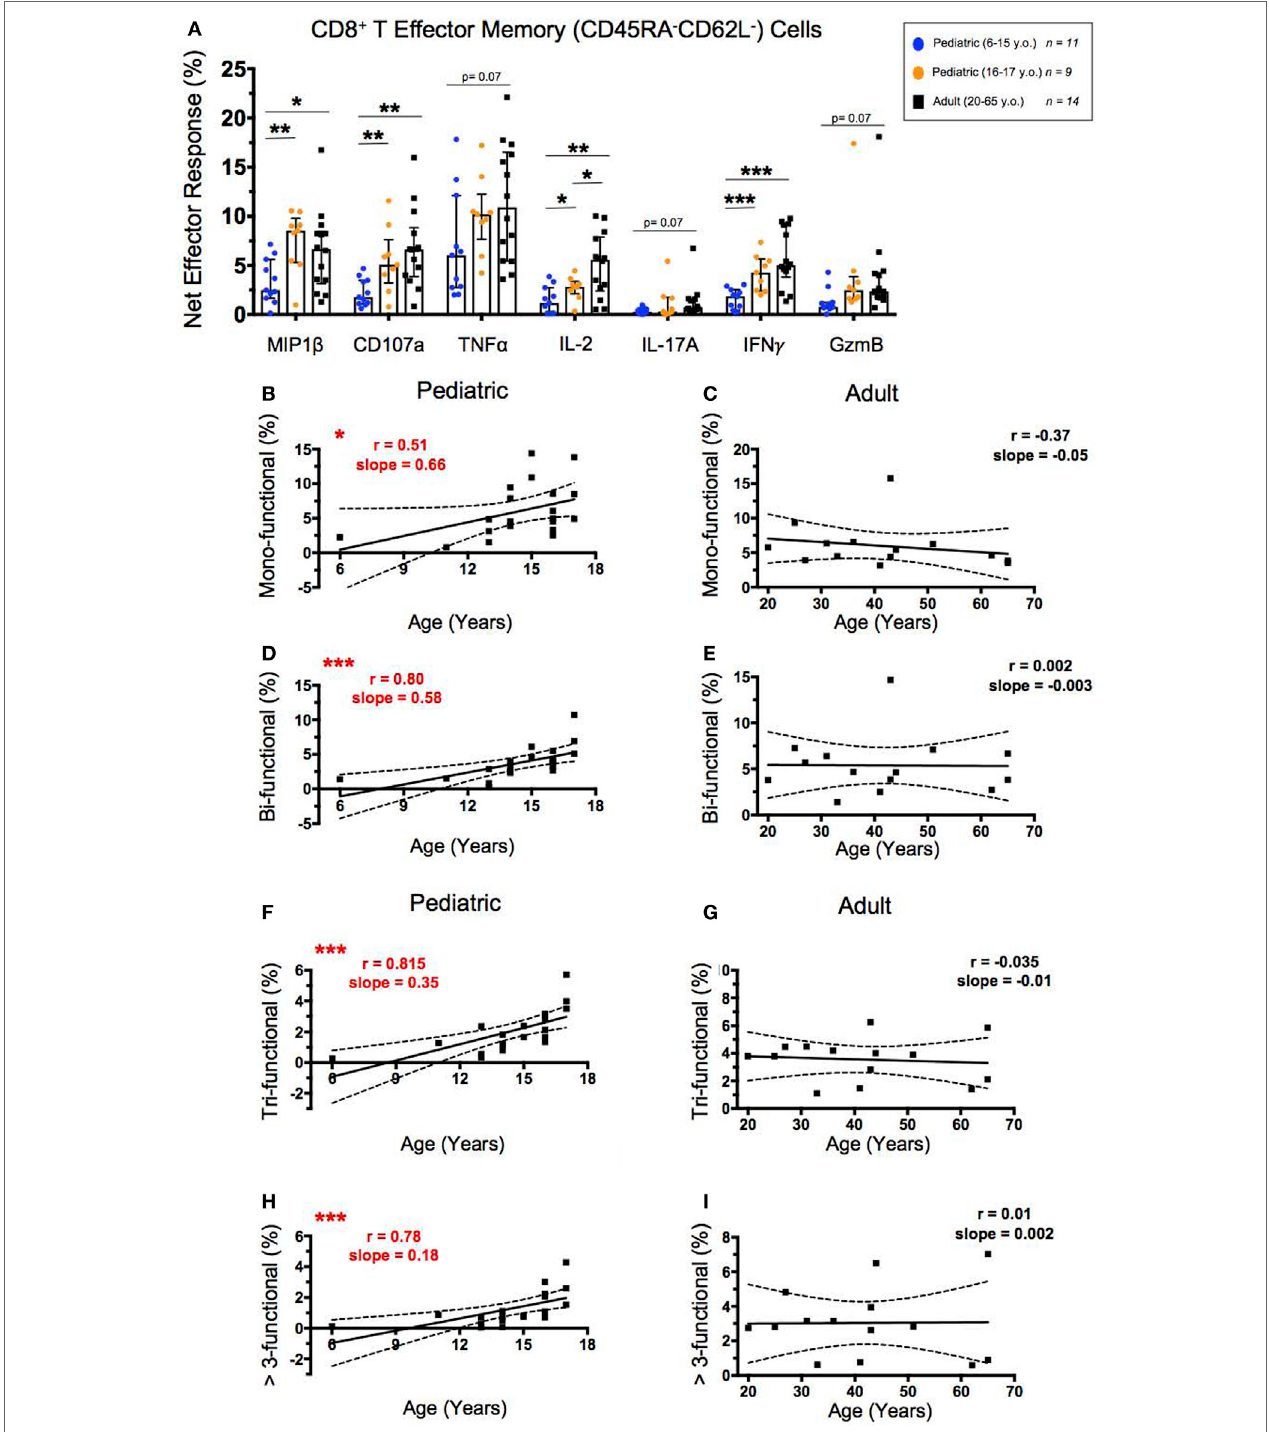
FigUre 4 | CD8 + T effector memory response. (a) Scatter plot showing the net percentages of CD8 + T EM producing MIP-1 β , CD107a, TNF- α , IL-2, IL-17A, IFN- γ , and Granzyme B (GzmB) following SEB stimulation. Results are shown for the following populations: 6–15-year-old pediatric ( n = 11), 16–17-year-old pediatric ( n = 9), and adult ( n = 14) participants. Bars represent medians with whiskers indicating interquartile ranges. Scatter plot statistics were analyzed by unpaired t -test (* p < 0.05; ** p < 0.01; *** p < 0.001). Line graphs represent linear regression with 95% confidence intervals among CD8 + T effector memory cell mono- (B,c) , bi- (D,e) , tri- (F,g) , and > 3- ( h,i) functional populations following SEB stimulation within participants between the ages of 6–17 ( n = 20) and 20–65 ( n = 14) years old. Line graph statistics were analyzed by Spearman r correlation (* p < 0.05; *** p <